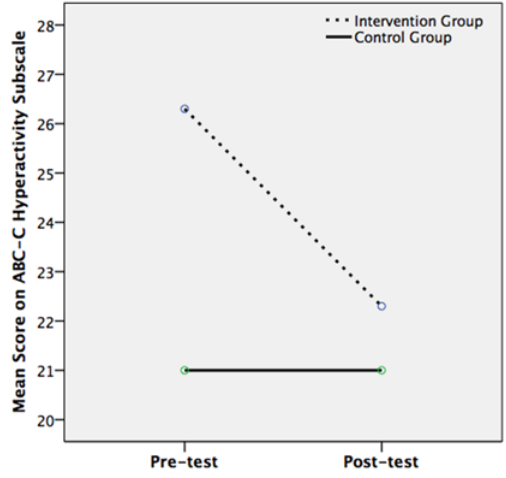
Figure 2. Mean Hyperactivity scores on the ABC-C at pre- and post-test for the intervention group ( n = 10) and control group ( n = 14).